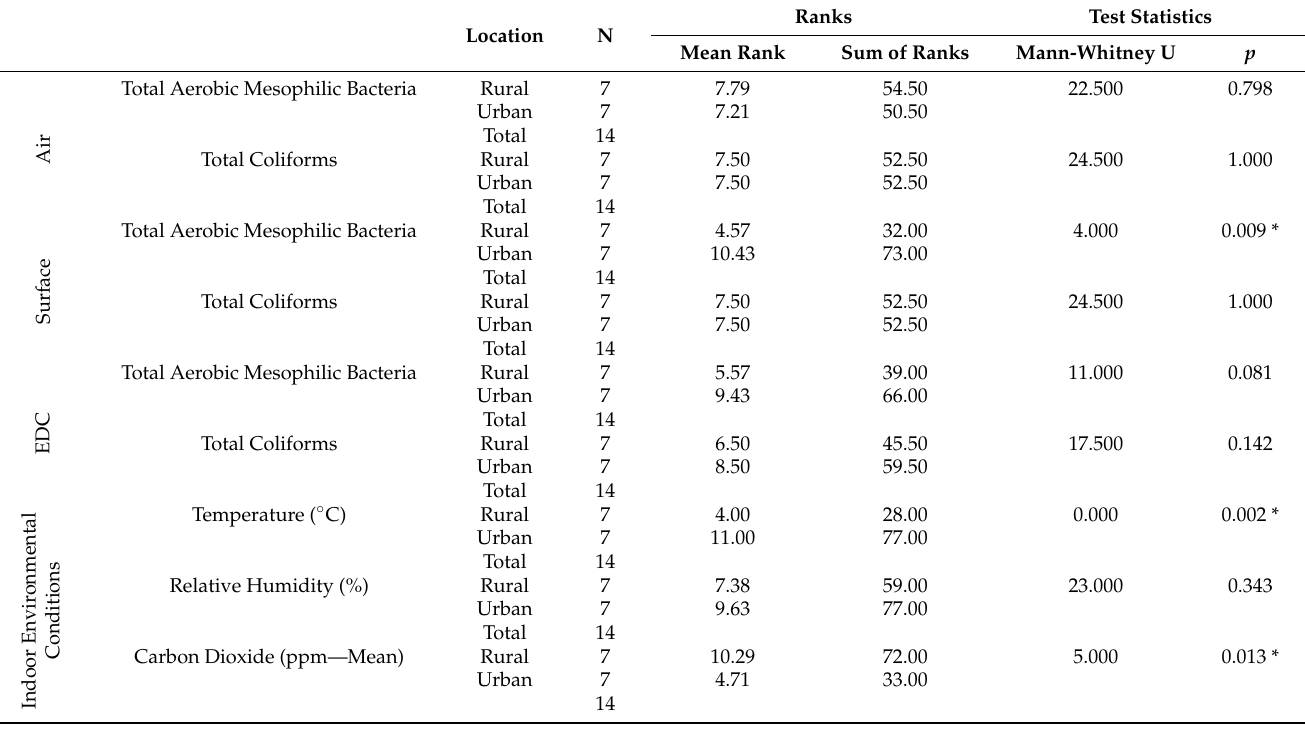
Table 6. Comparison of total aerobic mesophilic bacteria, total coliforms and environmental conditions (temperature, relative humidity and carbon dioxide concentration) between rural and urban PHCC: results of the Mann-Whitney test. Location N